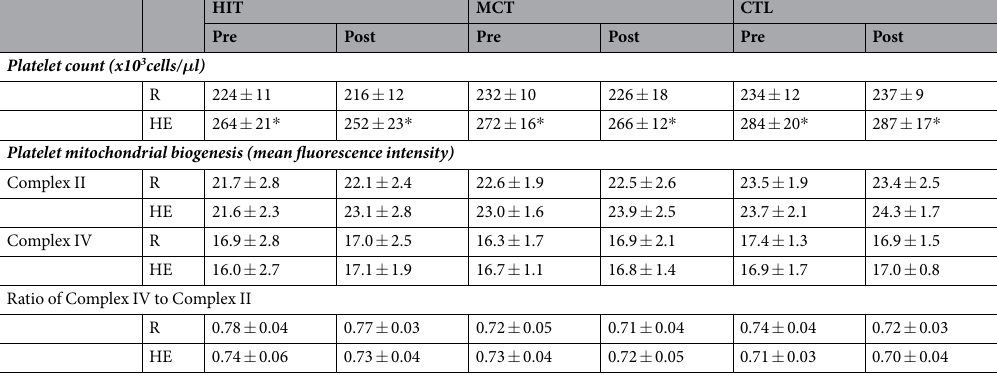
Table 2. The effects of interval and continuous exercise regimens on platelet count and mitochondrial biogenesis. Values were mean ± SEM. HIT, high-intensity interval training group; MCT, moderate-intensity continuous training group; CTL, control group; Pre, pre-intervention; Post, post-intervention; R, resting; HE, hypoxic exercise test. * P < 0.05, R vs.